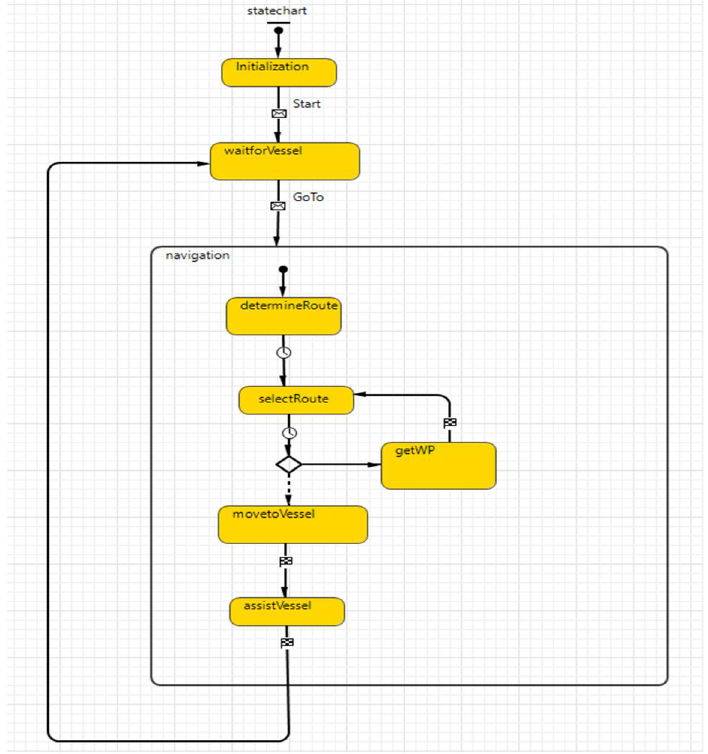
Figure 4. Statechart for icebreaker agents.